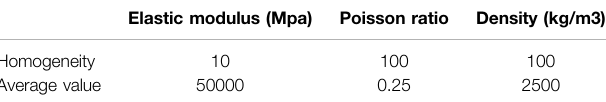
TABLE 2 | Rock material properties.